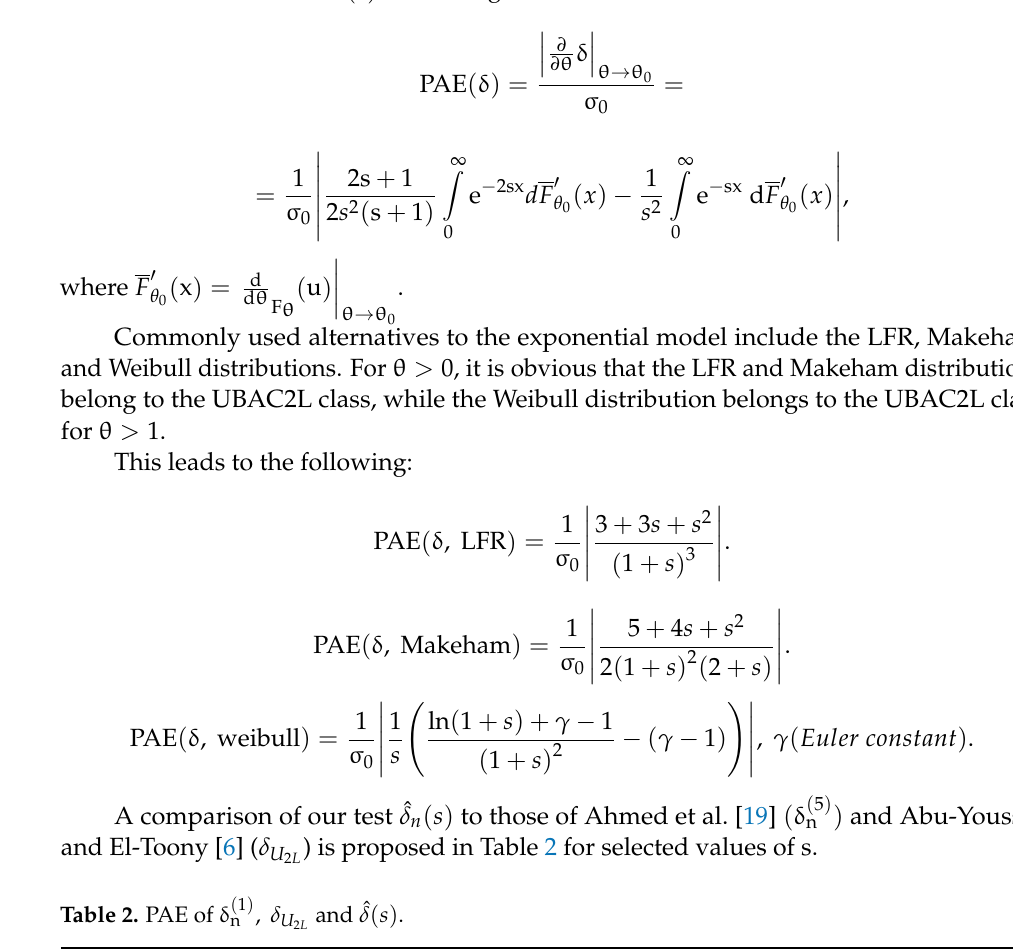
Table 2. PAE of δ